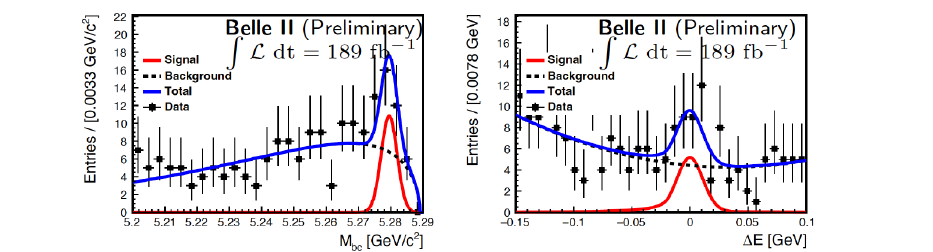
Figure 8. M bc (left) and ∆ E (right) projection for B → K ∗ `` decay. Points with error bars are su- perimposed on the blue (solid) curve showing total fit result, while red (solid) and black (dotted) lines represent the signal and background components.